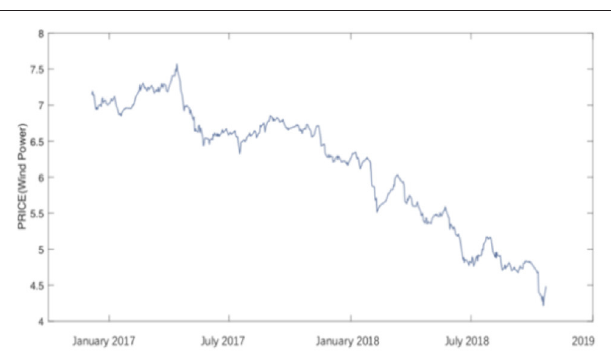
FIGURE 3 | Carbon efficiency.